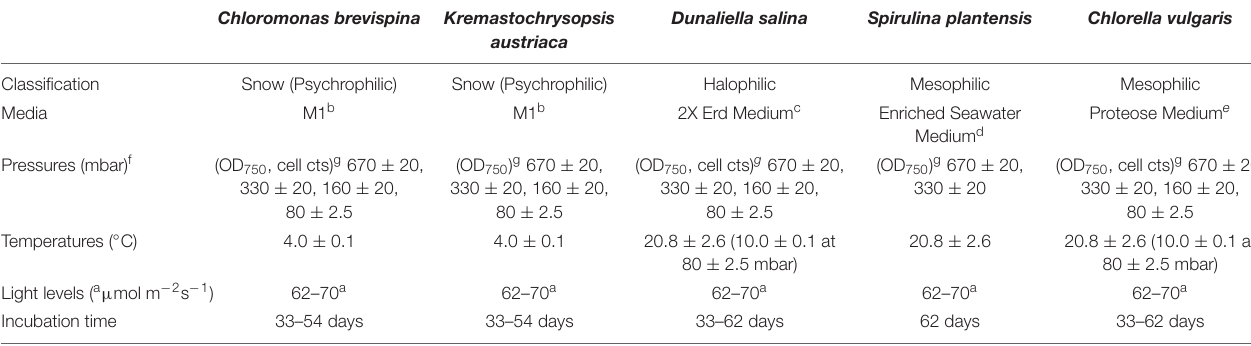
TABLE 1 | Selected algae species and their growth conditions.